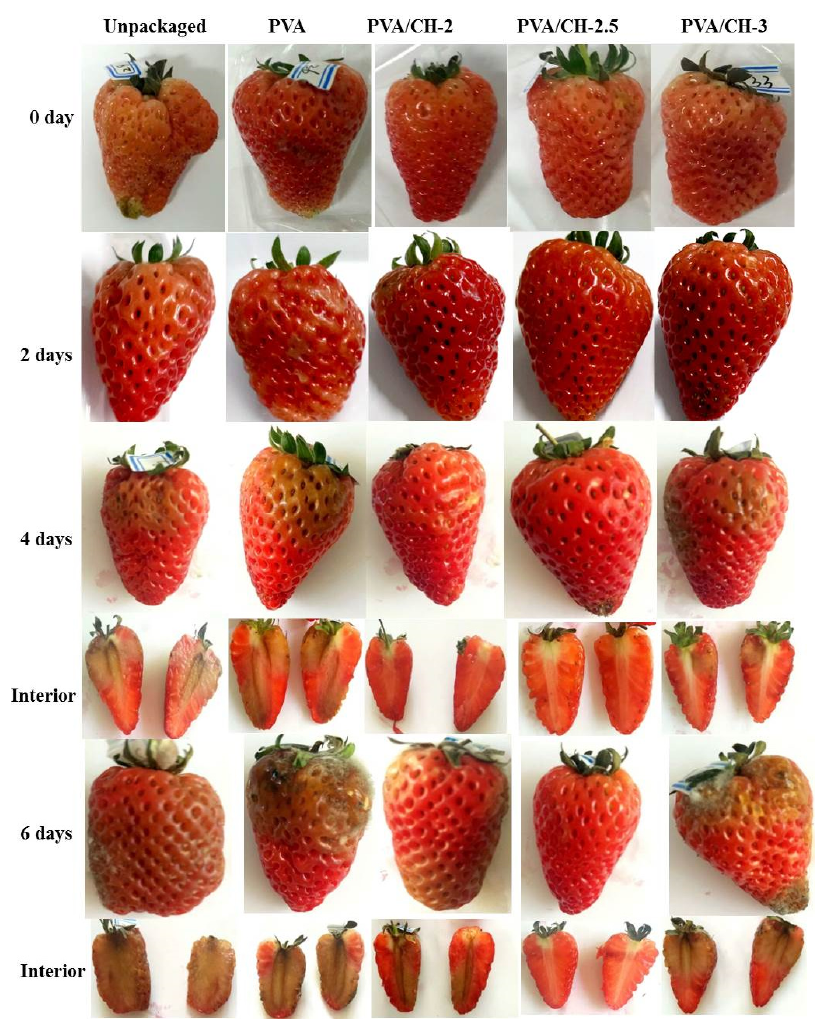
Coatings 2017 , 7, 109